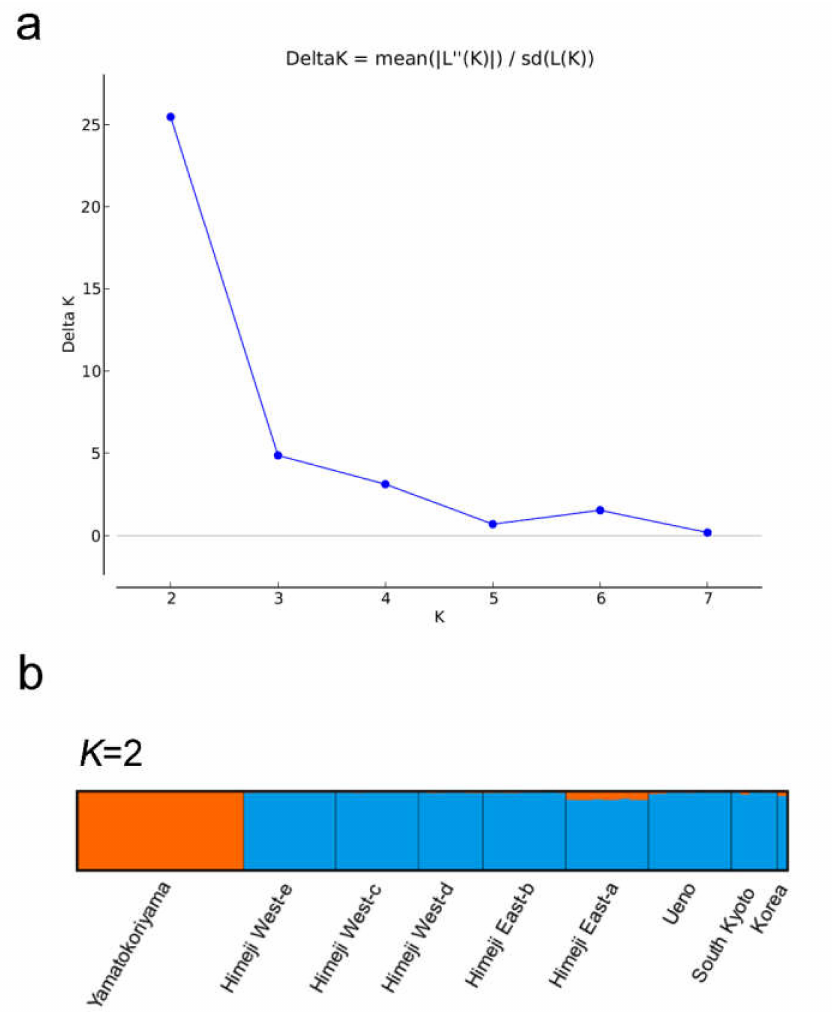
Figure 4. Hierarchical genetic population structure analysis of H. radiata . ( a ) Estimation of the optimal K value. ( b ) Result at the optimal value ( K = 2). Populations are separated by vertical lines, whose names are listed below bar plots. Orange and blue colors of bar plots correspond to the sum of assignment probabilities from the clusters at each